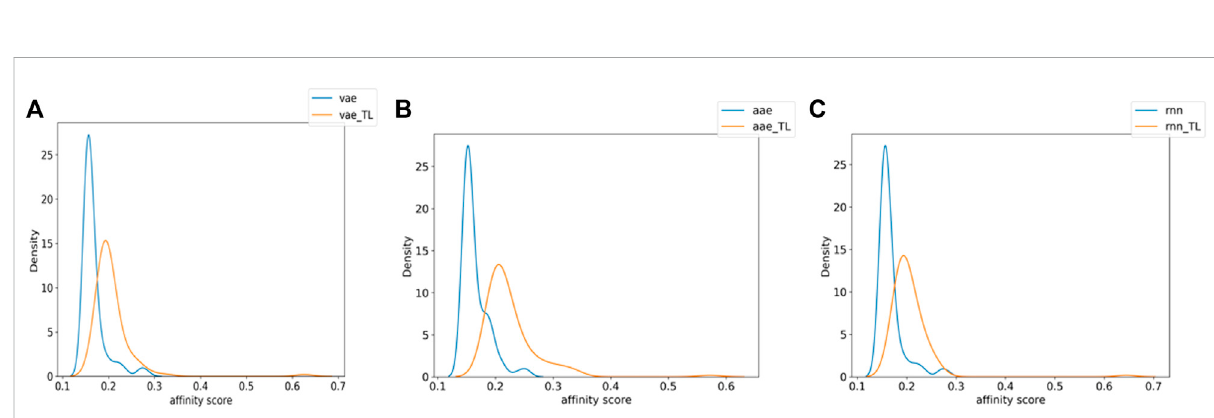
FIGURE 3 The numerical af fi nity distribution of molecules generated by each model with or without transfer learning [ (A) VAE, (B) AAE, (C)